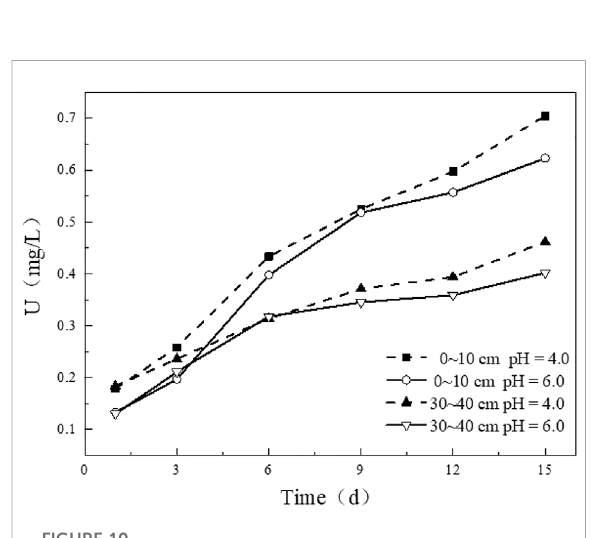
FIGURE 10 Variation of uranium leaching concentration in tailings samples at different